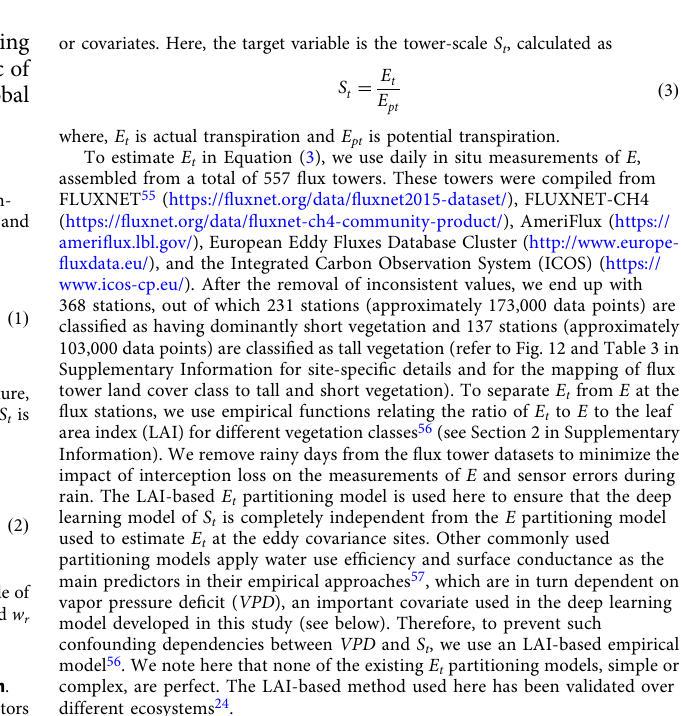
Fig. 6 Correlation of modeled transpiration stress and evaporation with global datasets. a , c Comparison of correlation maps for transpiration stress factor ( S t ) between processed-based and hybrid models with observational SIF / PAR . b and d , Comparison of correlation maps for evaporation ( E ) between processed-based and hybrid models with machine learning-based estimates (FLUXCOM). e Difference between a , c . f Difference between b and d